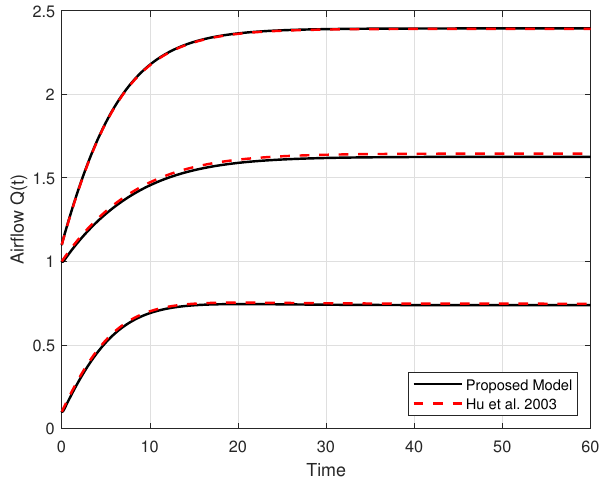
Figure 2. Model comparison on the mass flow rate in the ventilation network [3].